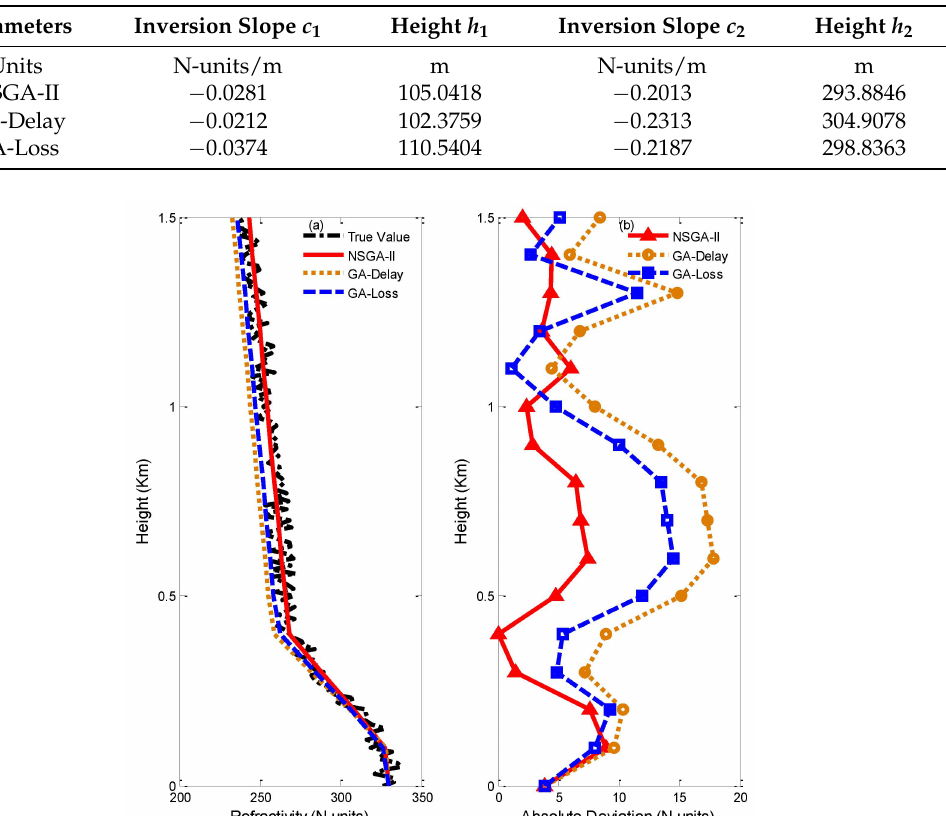
Figure 4. Inversion results of NSGA-II and GA. ( a ) The refractivity profile. ( b ) The corresponding refractivity